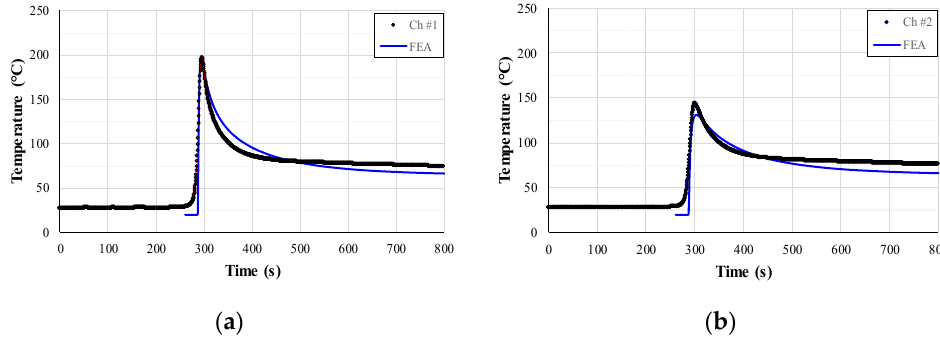
Commented [M1]: Please change the terms into scientific notation in the figure. (e.g., “8 × 10³”, not “8E3”)